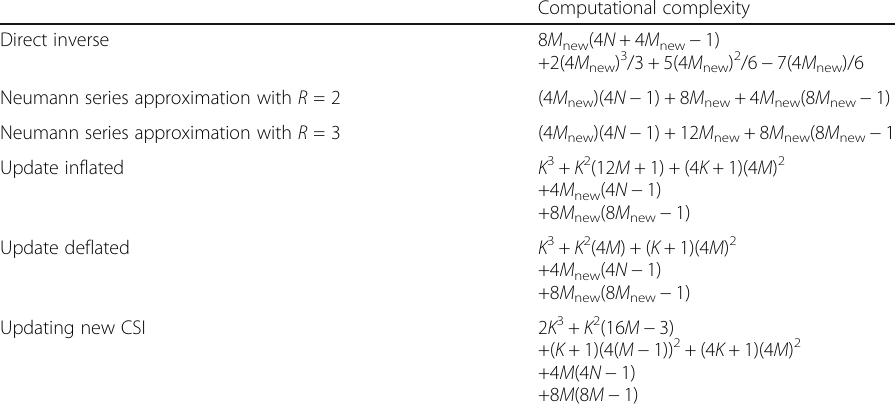
Table 1 Computational complexity of the proposed algorithms for the ZF STBC decoder